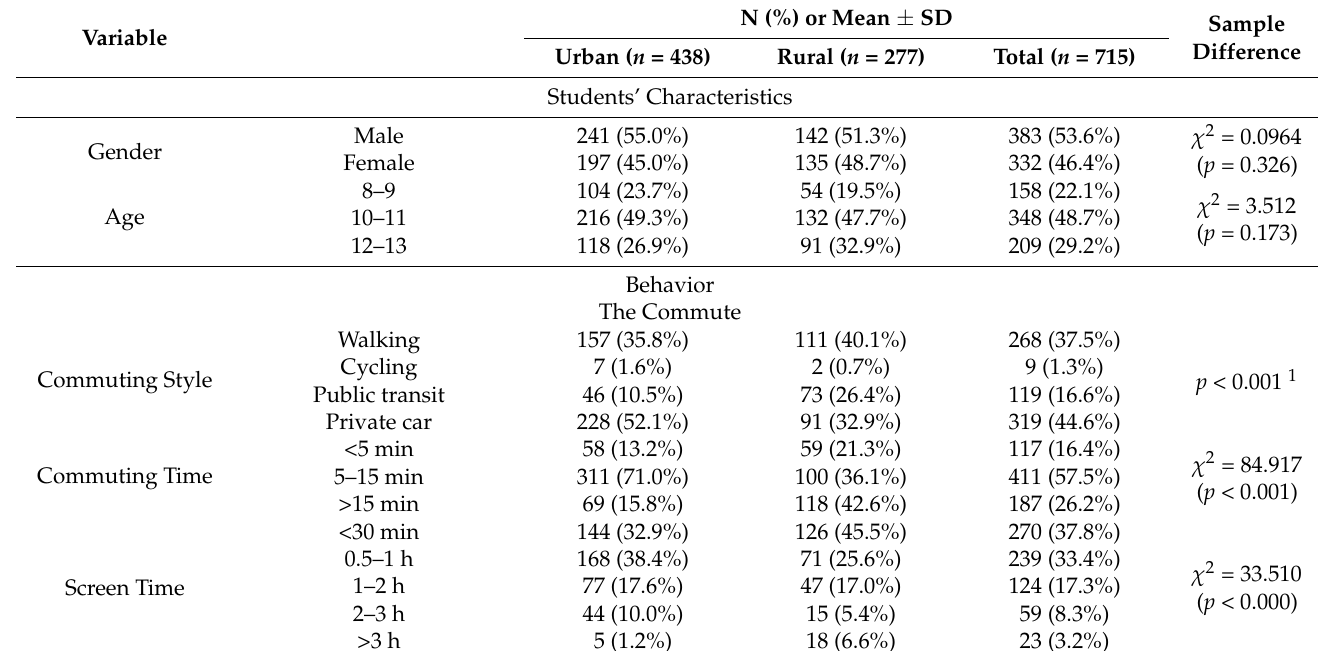
Table 2. Key Variables of Urban vs. Rural Students: Descriptive